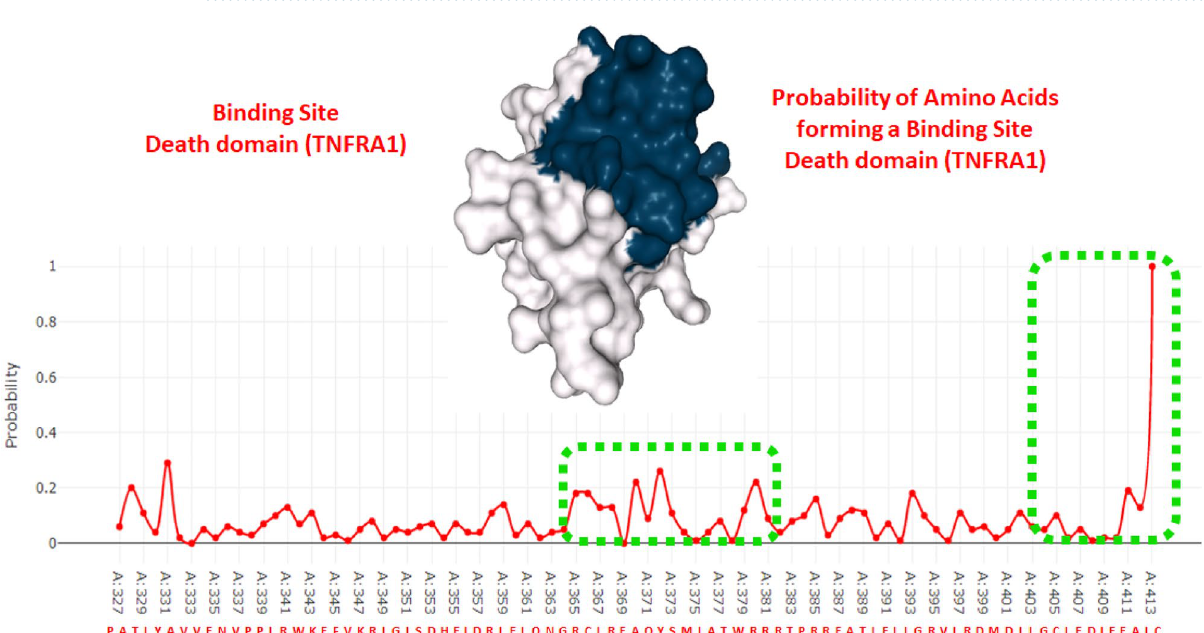
Figure 4. The binding pocket of MADD death domain showing probability of amino acids of forming a binding site.